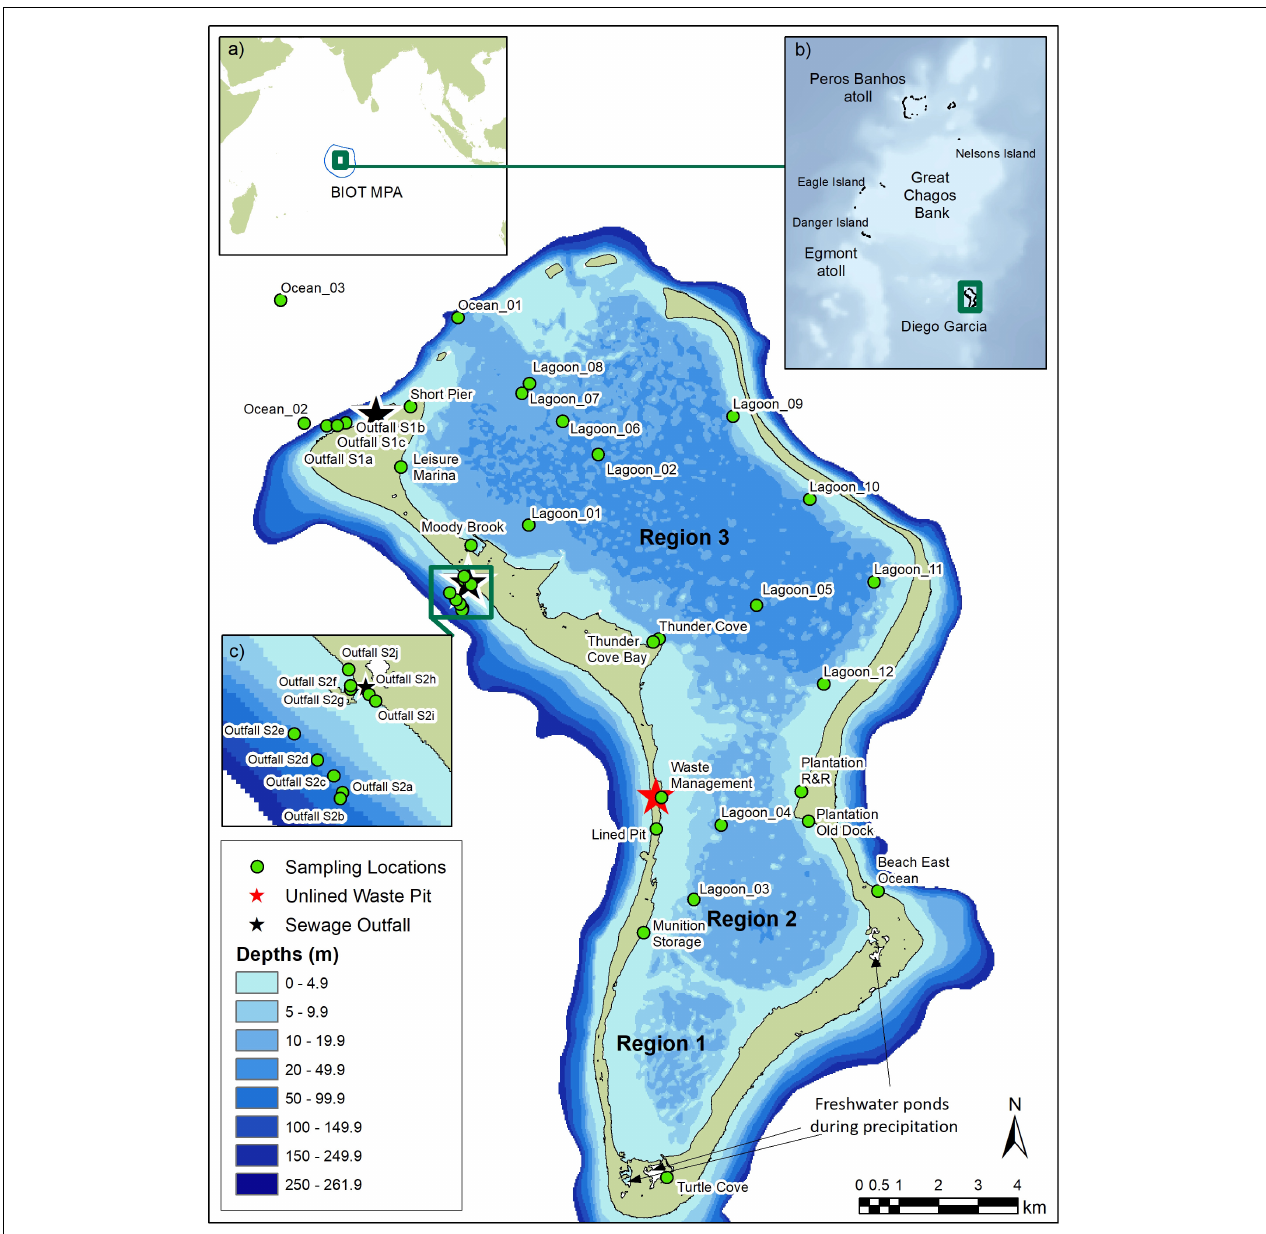
FIGURE 1 | Map of Diego Garcia showing sampling stations in Regions 1 to 3 in the lagoon, the location of lined and unlined waste pits, and freshwater ponds in Regions 1 and 2 which flow into the lagoon (Wang et al., 2014). Turtle Cove is a turtle breeding and hatching area. Insets indicate (a) the location of the British Indian Ocean Territory (BIOT) and extent of the Marine Protected Area (MPA; blue line), (b) atolls of the central Chagos Archipelago, and (c) sampling stations at sewage outfall